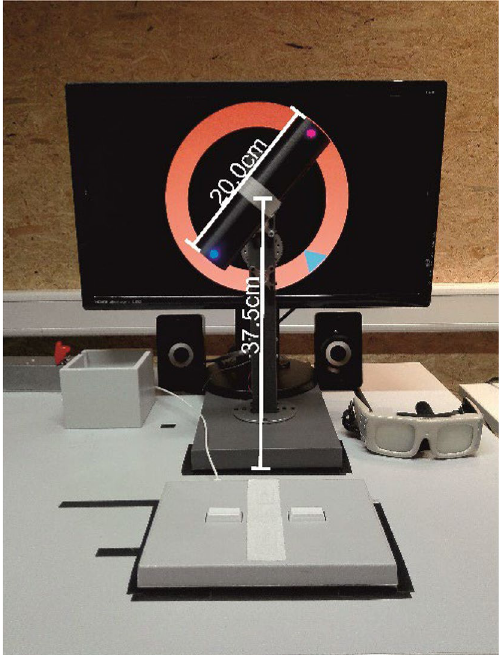
Figure 1. Experimental setup including shutter goggles (shown on the far right), response pad (middle front) and the turning-apparatus in front of a computer screen which was used to display stimulus material (target information): a triangular color cue (here blue, others: pink, yellow, or green) on an orange circle marked the target position. Participants grasped and turned the handle in a way that the same-colored dot on the handle would be aligned with the target arrow (e.g., blue to blue). The handle’s position was at a 90° angle to its target position and its LEDs either shined in the combination yellow-green or pink–blue.